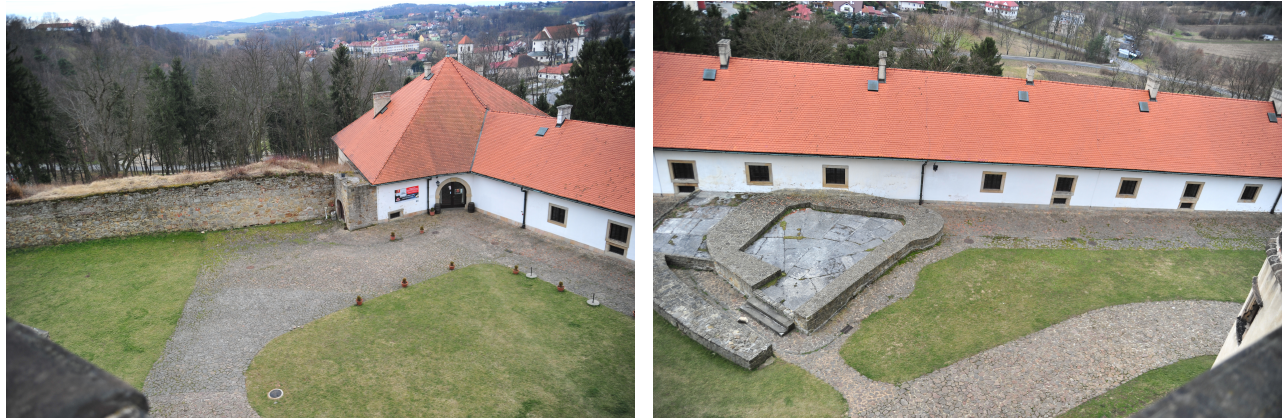
Figure 6. Examples of additional